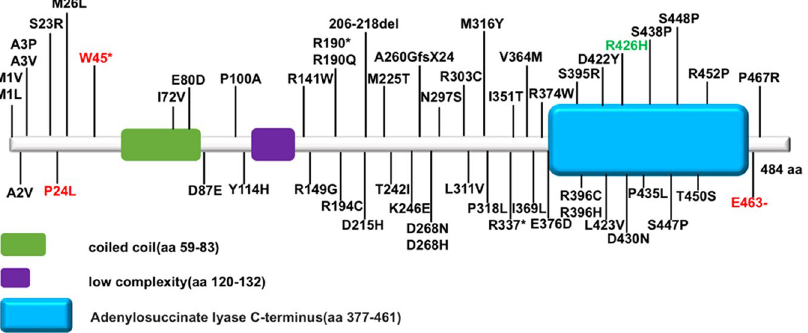
Figure 3. Mutations in ADSL protein. Note: aa, amino acid. Mutations in red are identified in our patients, mutation in green is the hot spot in European population. c.-49T > C, IVS5 -37 C > T and IVS12 + 1 G > C are not included in the figure. Schematic diagram was referred to SMART database (http://smart.embl-heidelberg. de). Mutations are referred to ADSL database (http://www1.lf1.cuni.cz/udmp/adsl/) and HGMD (http://www.